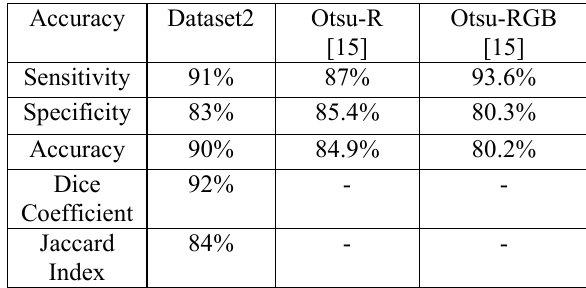
Figure 12. Images from PH2 Melanoma Dataset Table 3. Comparison result of Proposed Methodology